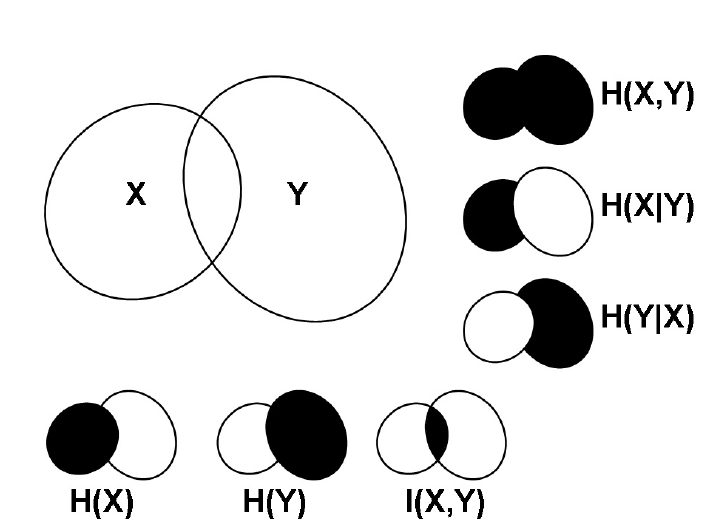
Graphical representation of the entropies ( H ( X ) , H ( Y ) ), joint entropy ( H ( X; Y ) ), conditional entropies ( H ( X | Y ) ; H ( Y | X ) ), and mutual information ( I ( X; Y ) ) of a pair of random variables ( X; Y